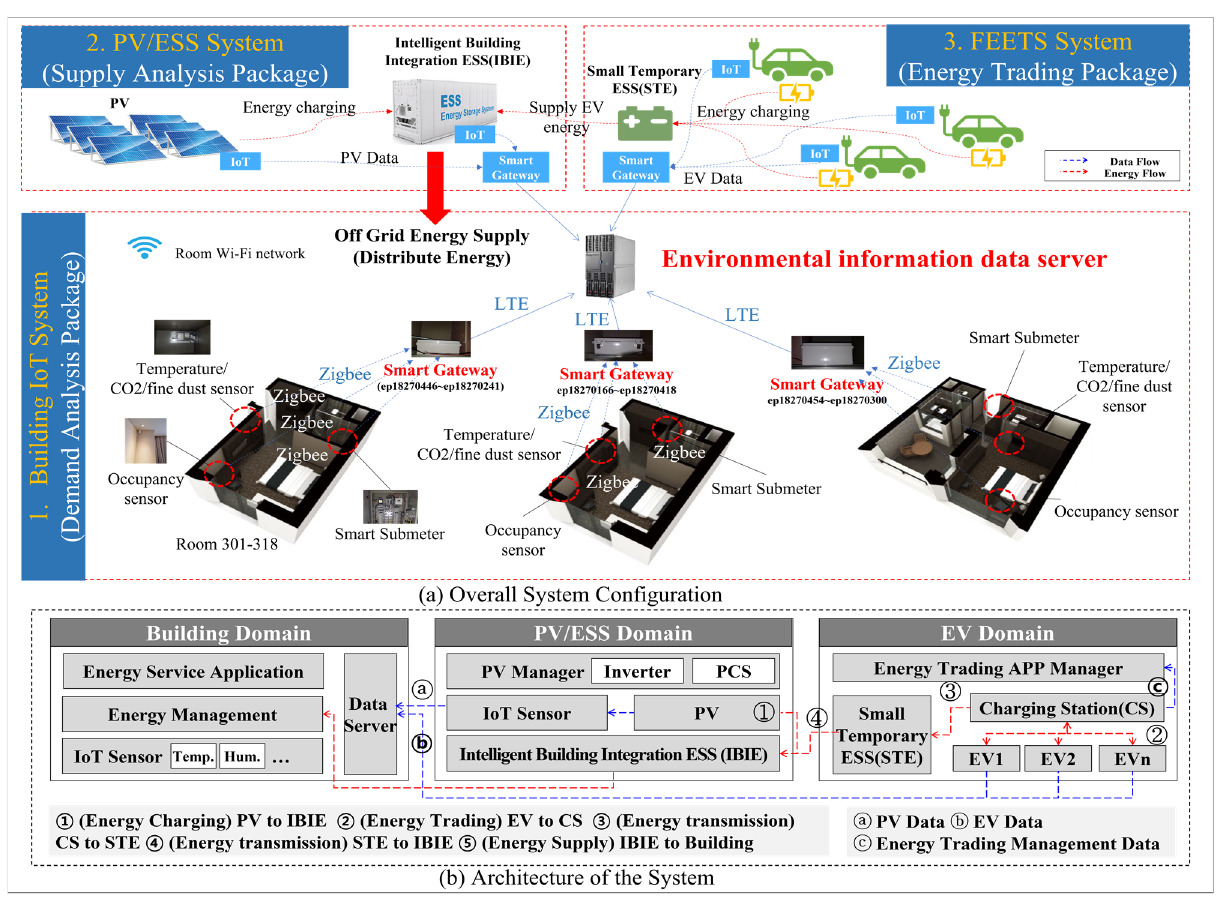
Figure 8. Connectivity between the IoT System built in the building, the PV/ESS platform, and the EV/V2G platform.